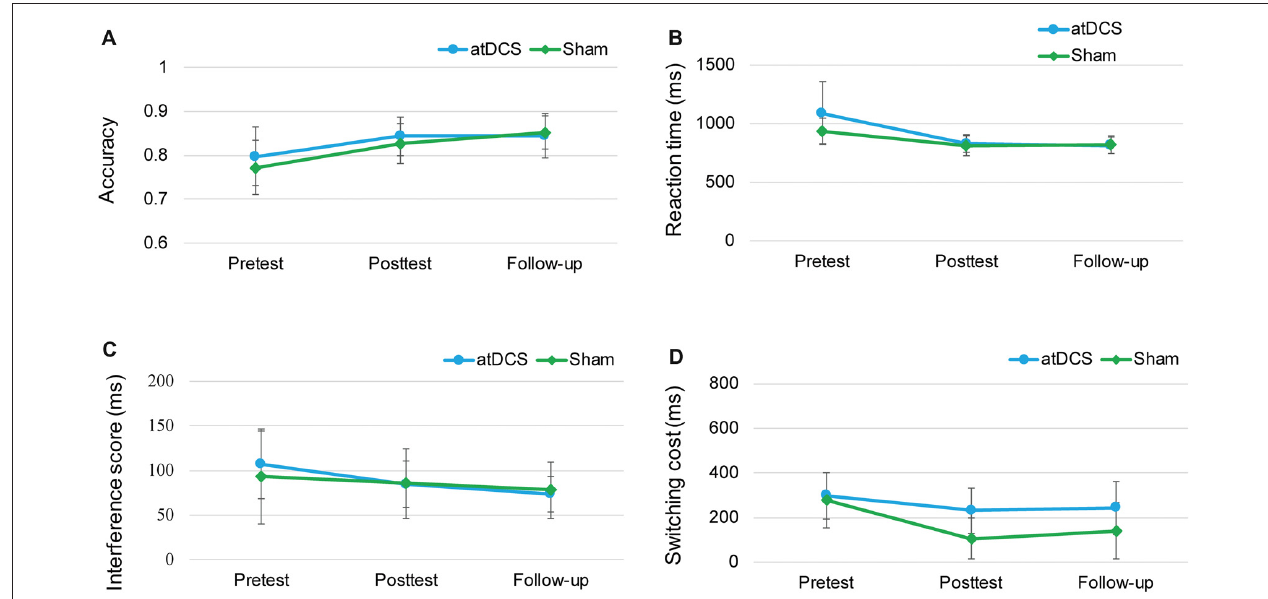
FIGURE 7 | The plots display the mean accuracy rate (A) and mean RT (B) of the two-back task, the mean interference score of the flanker task (C) and the mean switching cost of the switching task (D) in each group (anodal transcranial direct current stimulation and sham transcranial direct current stimulation) at pretest, posttest and follow-up. Error bars represent standard errors of the mean. atDCS, anodal transcranial direct current